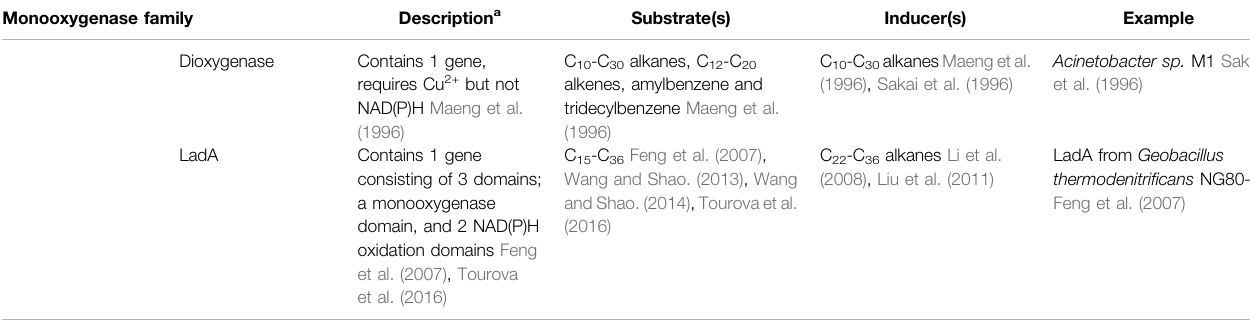
TABLE 1 | ( Continued ) Organisation and properties of bacterial monooxygenases involved in aliphatic hydrocarbon